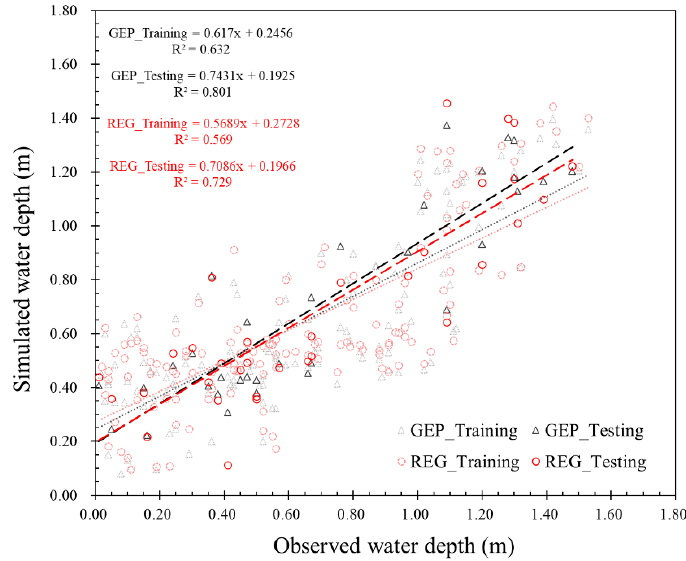
Figure 11. Bathymetry retrieval results from GEP and REG models.